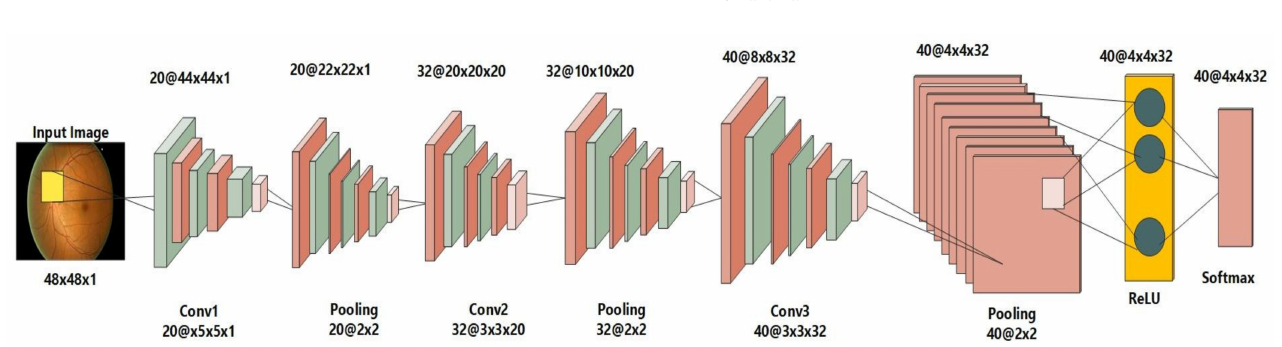
Figure 3. Deep CNN architecture for an input image.